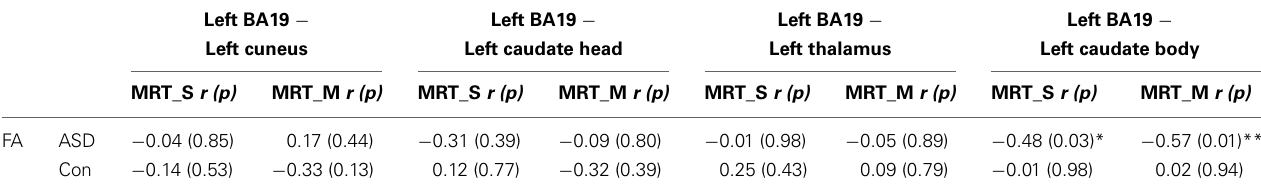
Table 6 | Results of correlation analysis between mean response times during a mental rotation task and the micro-structural diffusion measure of FA extracted from the white matter tracts linking functionally defined regions.